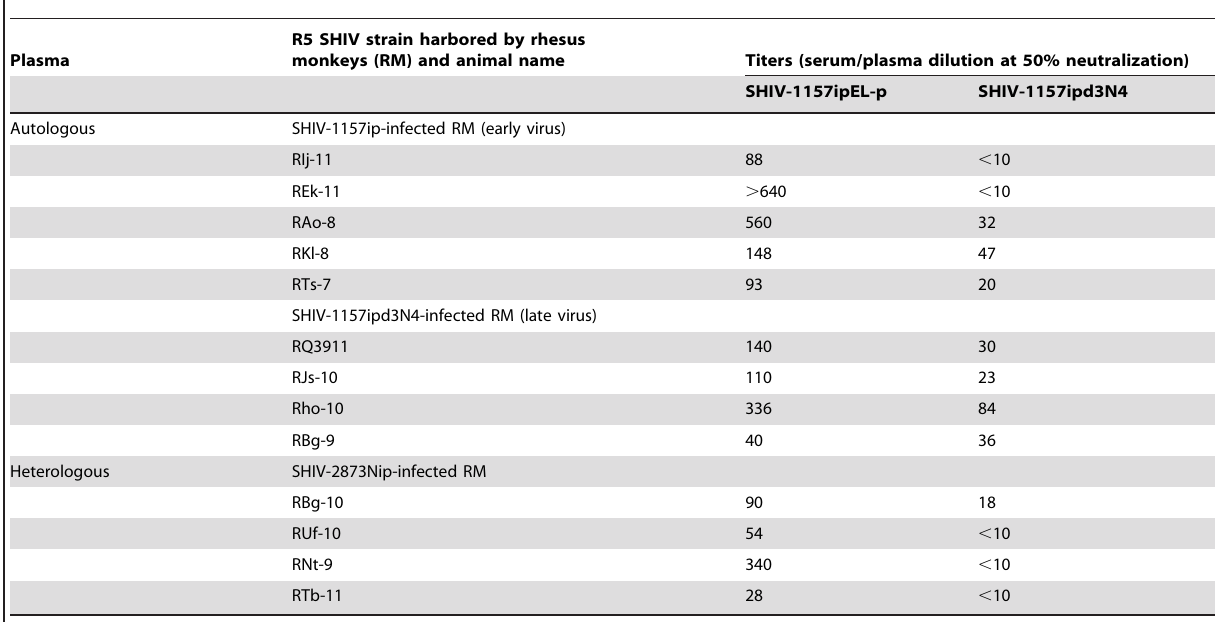
Table 3. Neutralization titers of autologous and heterologous polyclonal serum/plasma samples against SHIV-1157ipEL-p (early Env) and SHIV-1157ipd3N4 (late Env).